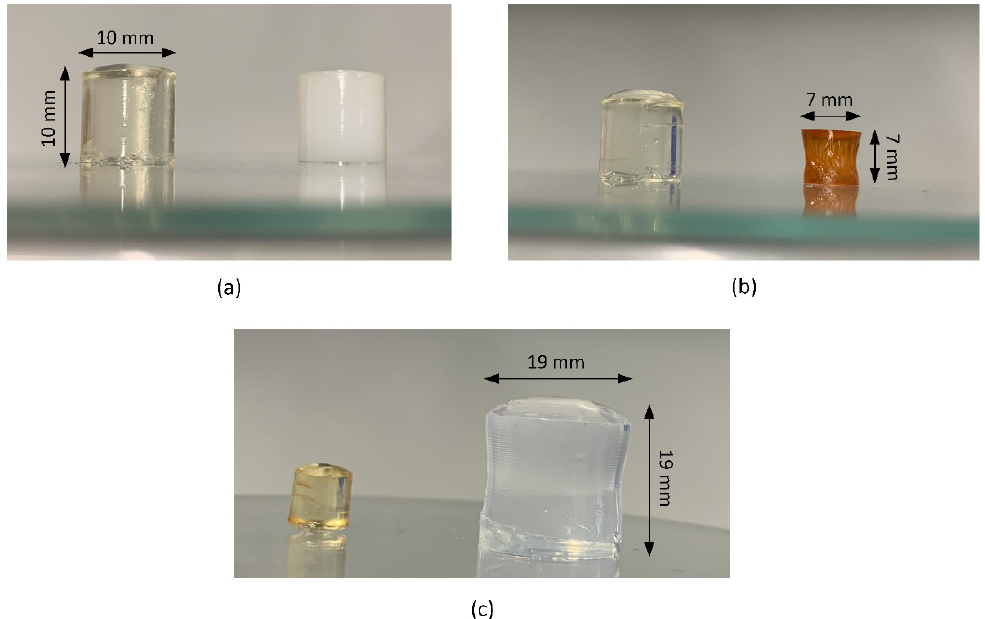
Figure 1. Cylindrical hydrogels ( a ) with different MBAA contents (left: 2 mol%; right: 5 mol%), ( b ) at different drying stages (left: without drying; right: after 5 d at 60 °C; 2 mol% MBAA) and ( c ) after swelling in water (left: unswollen; right: swollen for 24 h at 30 °C). Table 1. Hydrogel composition with different crosslinker